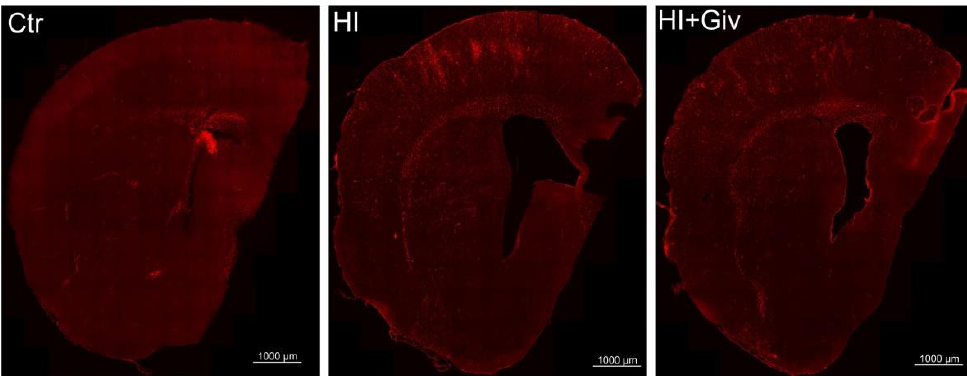
Figure 3. The effect of hypoxia-ischemia and Givinostat treatment on microglia activation pattern in the ipsilateral hemisphere. Confocal photomicrographs of brain sections from animals 7 days after HI, with or without Givinostat application, stained for activated microglia/macrophage marker — ED1 (red). Scale bar: 1000 µm. Confocal photomicrographs of ipsilateral hemispheres show a large number of ED1 stained cells after HI in cortex, striatum and corpus callosum. Application of Givinostat did not change the activation pattern of microglia after HI.